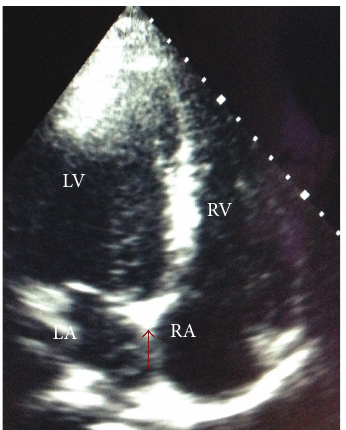
Figure 4: Modified apical 4-chamber view of TTE shows the bullet without pericardial